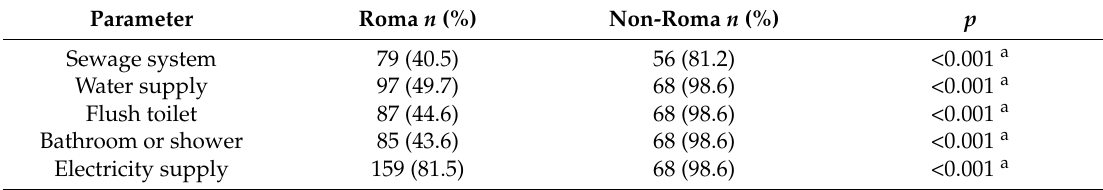
Table 3. Basic household facilities of respondents living in Roma settlements ( n = 195) and respondents from the general population ( n = 69).